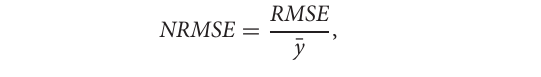
FIGURE 6 | Comparison of epidemiological data from Brazil with the best fit based on our theoretical model. Also shown near the end of the time series are the statistical forecasting 95% confidence intervals, as described in Section 3.5. The theoretical fit is obtained with τ The number of official confirmed cases in Brazil compared with the theoretical prediction. (B) Time evolution of the official number of recovered cases in comparison with the theoretical prediction. (C) The number of official deaths compared with the theoretical prediction. (D) The time evolution of the official number of active cases in Brazil compared with the theoretical prediction. In all cases the functions κ ( t ), λ ( t ), and ρ ( t ) vary in time according to Figure 5